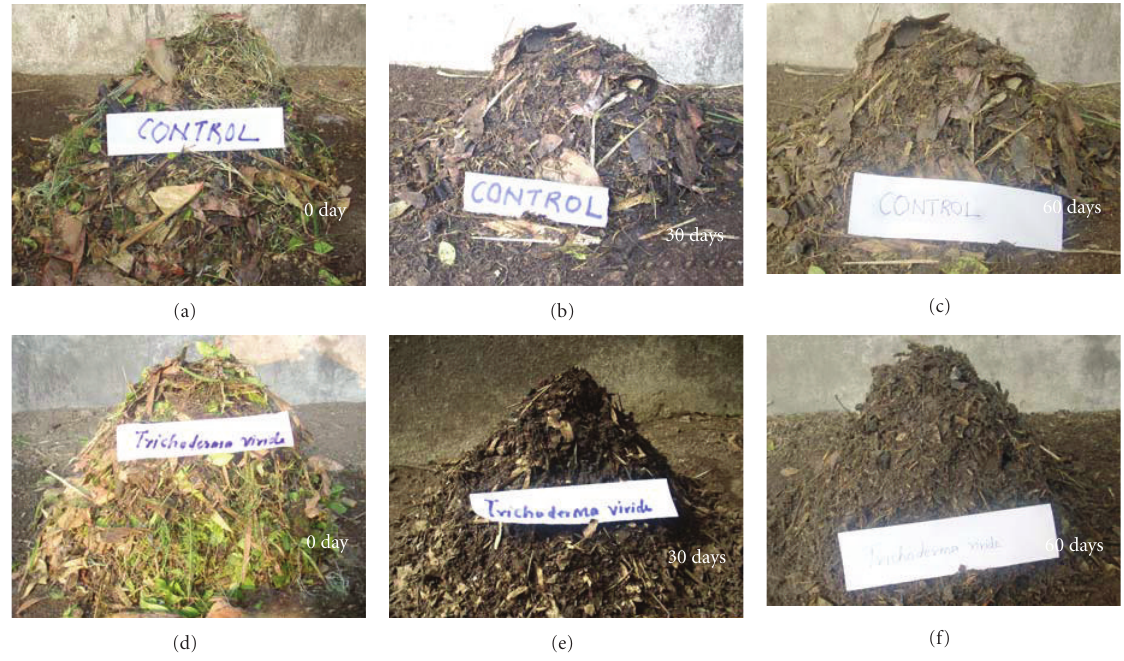
Figure 5: Bioconversion of municipal solid waste by T. viride using spore suspension in small piles.